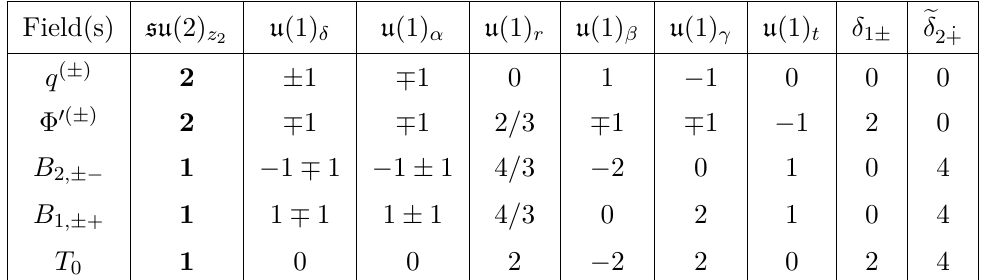
= αδ, z ) which can be 1 2 = r + 2 j 4 q t ± 2 j 1 and 1 ± 2 − 3